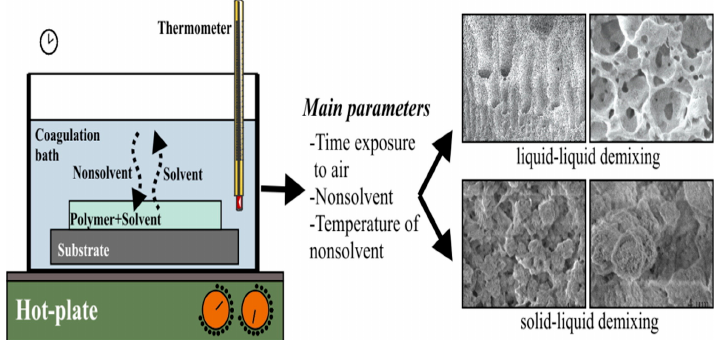
Figure 7. Porous scaffolds produced by non-solvent induced phase separation (NIPS). Reproduced with permission from [112], published by Elsevier, 2015.